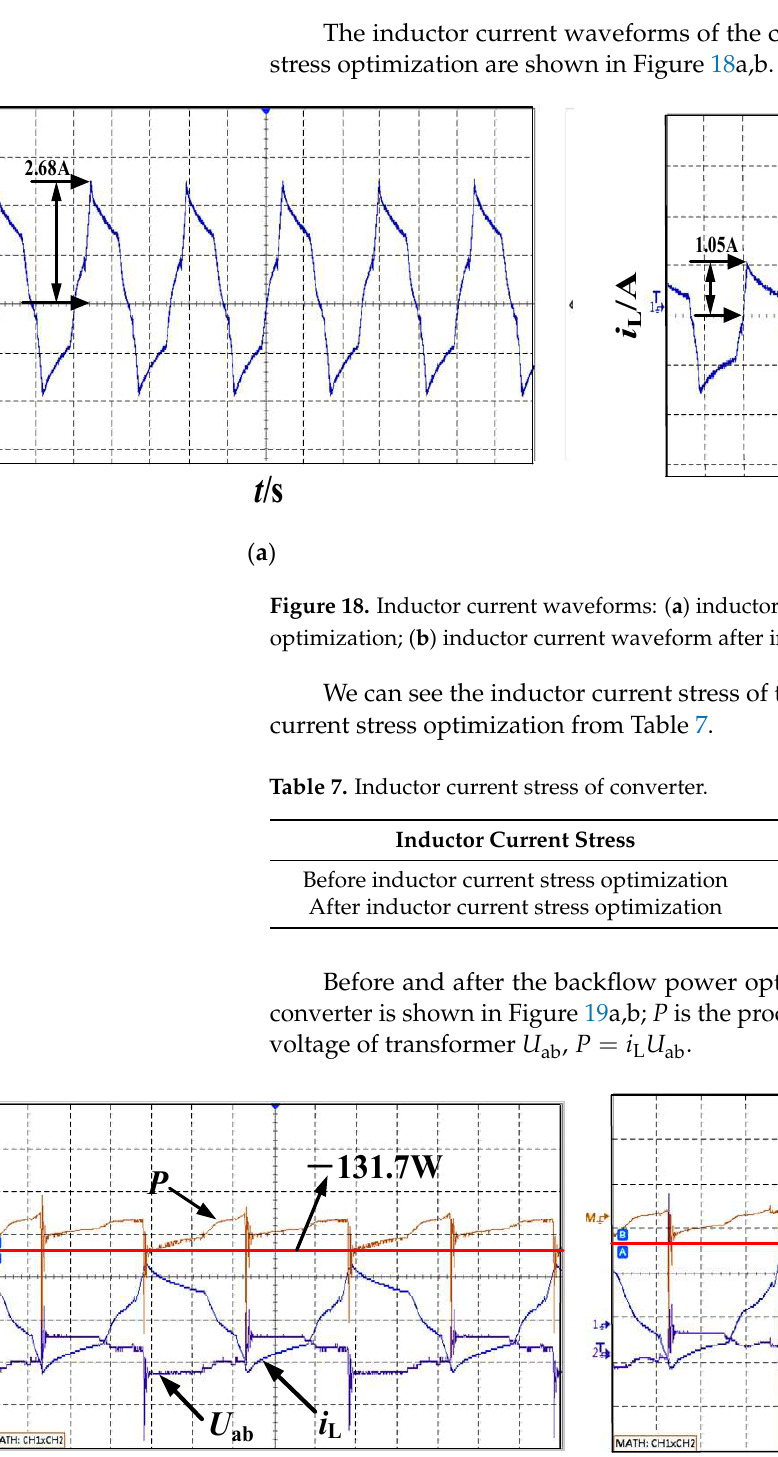
( d ) Figure 17. Output voltage of the DAB under different control strategies: ( a ) traditional double closed-loop control; ( b ) traditional VDCM control; ( c ) J and H adaptive VDCM control; ( d ) J , H, and 𝑅 (cid:2911) adaptive VDCM control. 𝑈 (cid:2923)(cid:2919)(cid:2924) is the minimum value of the output voltage, under different control strategies, and the fluctuation peak and recovery time of output voltage 𝑈 (cid:2925) are shown in Table 6; we can see the DC bus voltage has the smallest fluctuation peak and the shortest recovery time under three-parameters adaptive VDCM from Table 6. Table 6. Fluctuation peak and recovery time of 𝑈 (cid:2925) under different control strategies.